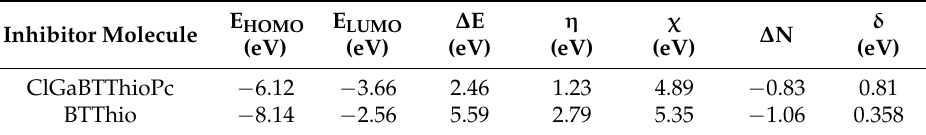
Quantum chemical parameters for ClGaBTThioPc and BTThio obtained at B3LYP/6-31++(d,p)